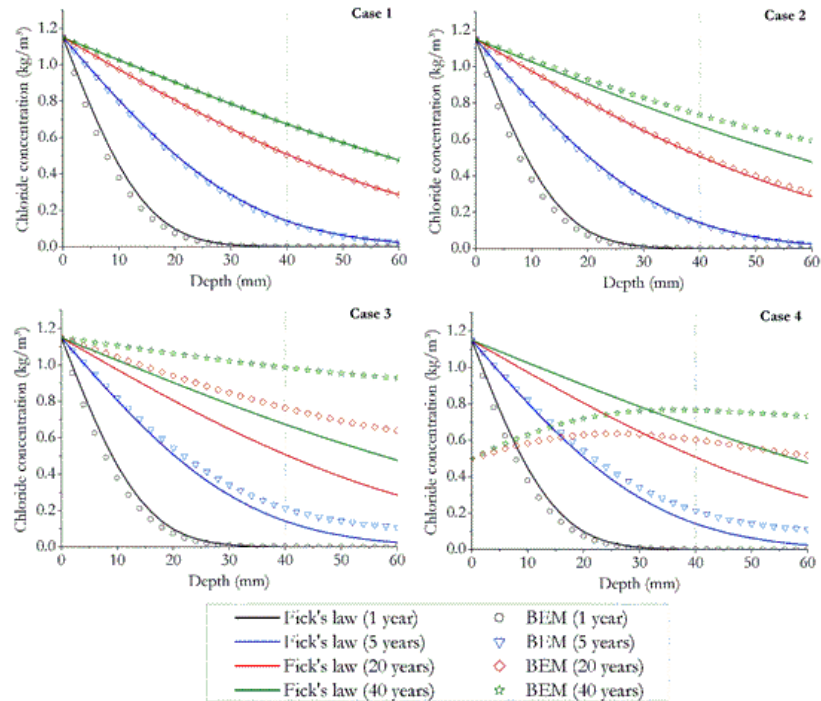
Figure 7 – Chloride profiles evolution along time for the four different boundary